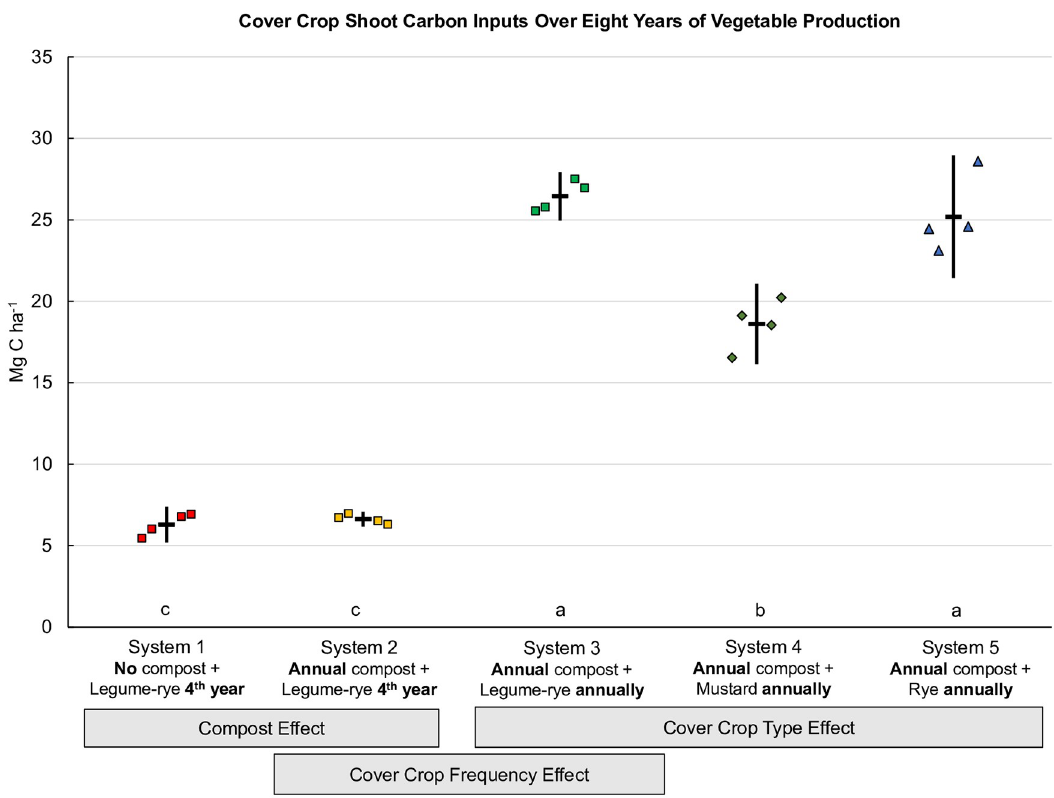
Fig 2. Cover crop shoot carbon inputs over eight years of vegetable production. Measurements were taken in five organic vegetable systems in Salinas, CA. Systems differed by annual compost additions (0 vs. 7.6 Mg ha -1 before each vegetable crop), cover crop type (legume-rye, mustard, or cereal rye alone) and cover cropping frequency (quadrennially vs. annually planted). Error bars are 95% confidence limits. Individual data points for reps 1 through 4 of each system are clustered in order from left to right around the mean, which is represented by the horizontal lines. Different lower case letters above the x-axis indicate that the shoot carbon means are significantly different based on the Tukey-Kramer adjusted family-wise error rate of (P � 0.05). Mean cover crop shoot carbon inputs (Mg ha -1 ) were 6.3 (System 1), 6.6 (System 2), 26.4 (System 3), 18.6 (System 4) and 25.2 (System